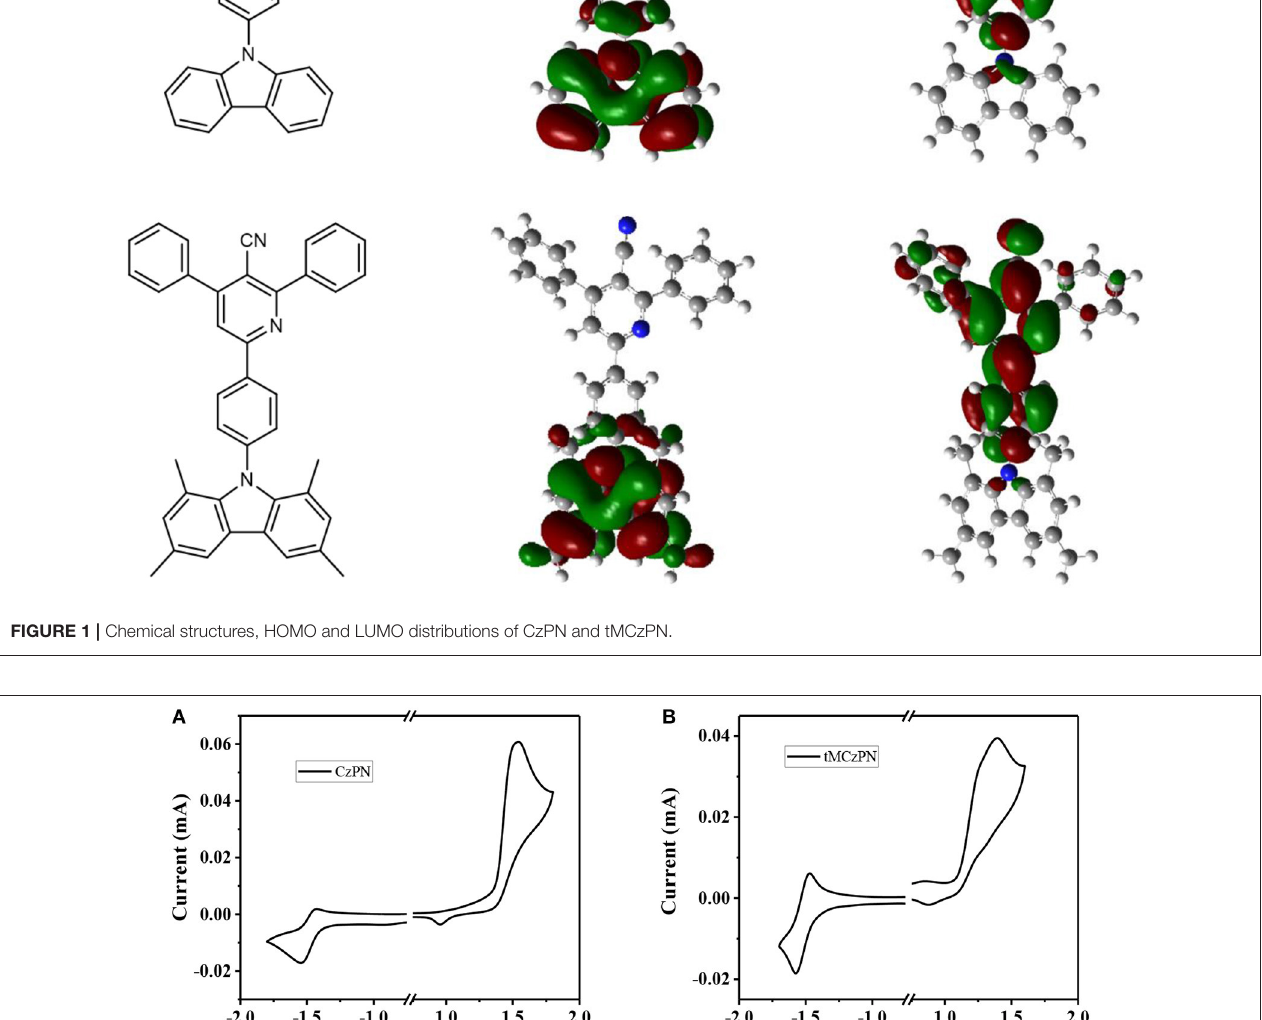
Frontiers in Chemistry |